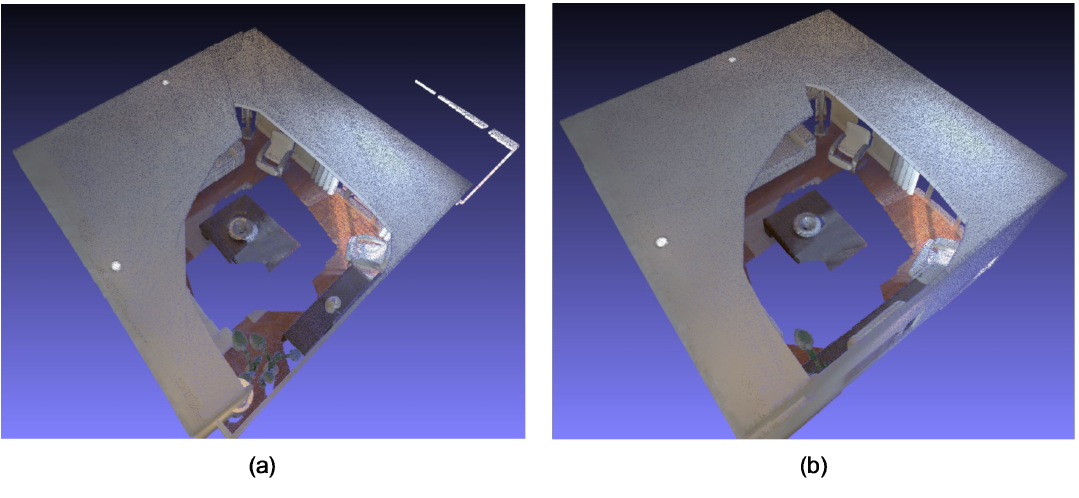
Figure 7. 3D reconstruction result comparison with bundle adjustment [35]. ( a ) 3D model from [35]; ( b ) 3D model from the proposed